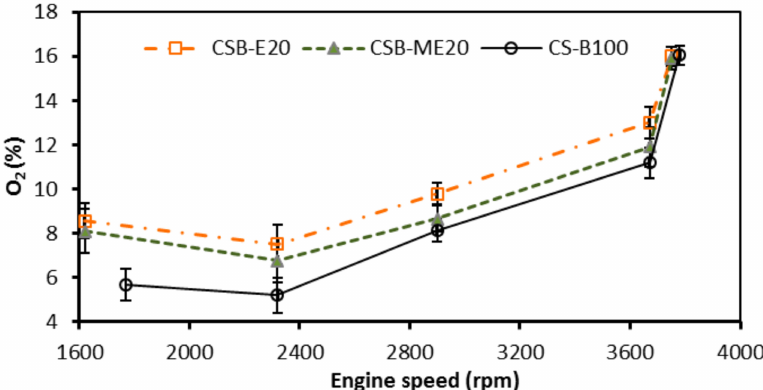
Figure 14. The relationship between engine speeds (rpm) and O 2 (%) for CS-B100, CSB-E20 and